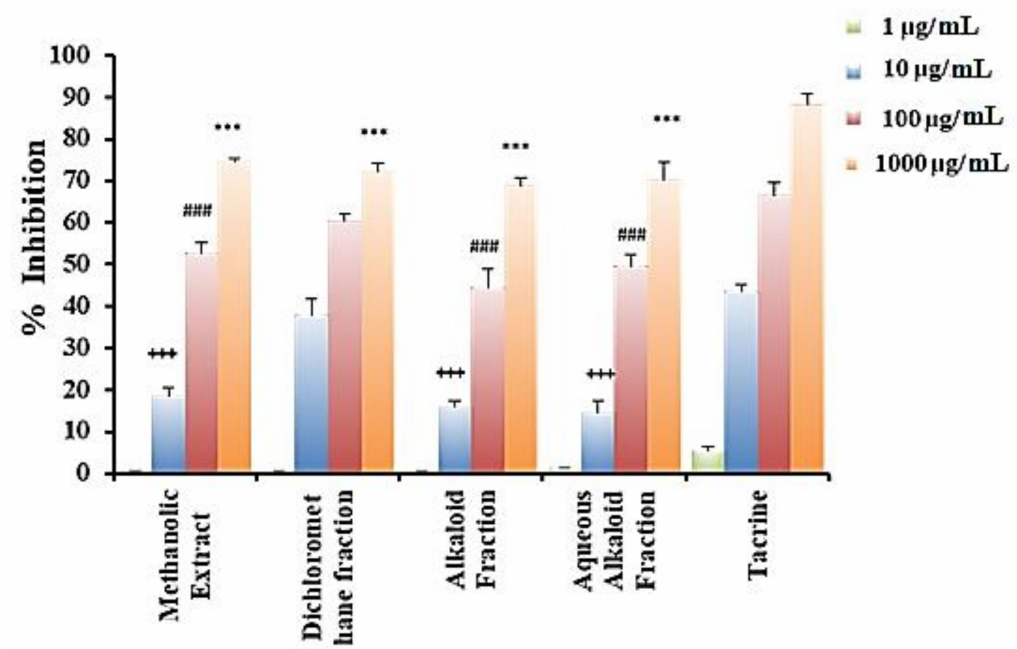
Figure 2. Percentage inhibition of the different A. canariense L. extracts. Note: *** p < 0.001 significant values compared to tacrine 1000 µ g/mL; ### p < 0.001 significant values compared to tacrine 100 µ g/mL; +++ p < 0.001 significant values compared to tacrine 10 µ